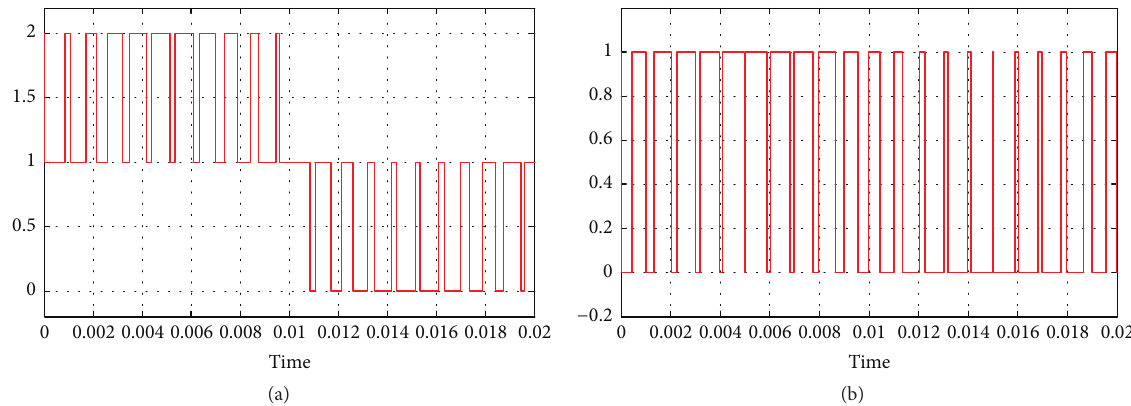
Figure 5: Pulses conventional inverter: (a) three-level inverter and (b) two-level inverter.